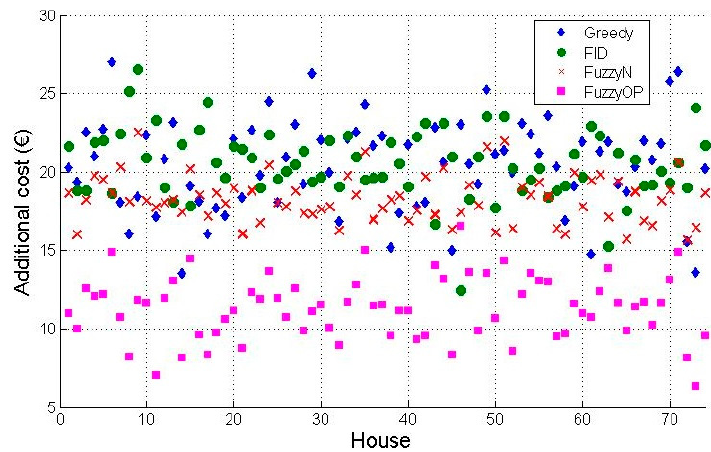
Figure 12. Additional costs compared to the perfect foresight method. FuzzyOP: optimized Fuzzy. Table 4. Outperformance times of different power dispatch method in 74 houses.